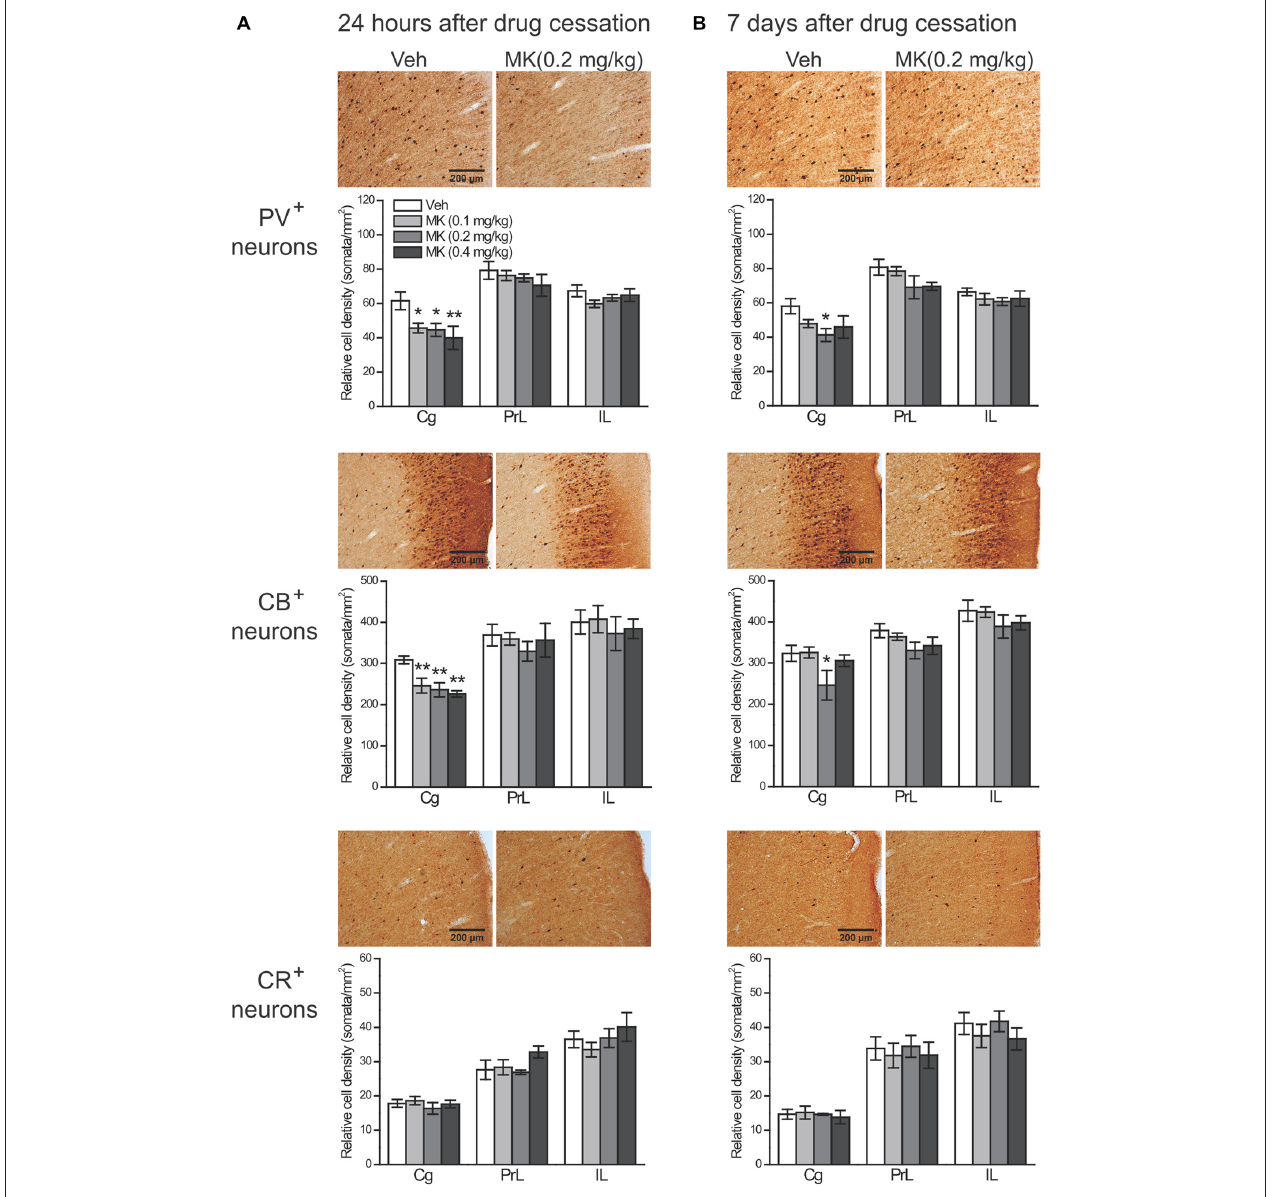
FIGURE 4 | Effects of subchronic treatment of MK-801 (0.1, 0.2, 0.4 mg/kg, once daily) during adolescence (PND 29–42) on relative density of PV + , CB + and CR + neurons in rat mPFC 24 h (A) and 7 days (B) after drug cessation. Representative sections show immunoreactivity of each type of neurons in the cingulate subregion in animals receiving either vehicle or MK-801 (0.2 mg/kg) treatment. n = 4 per group. ∗ p < 0.05, ∗∗ p < 0.01 compared with the vehicle group. Cg, cingulate cortex; PrL, prelimbic cortex; IL, infralimbic